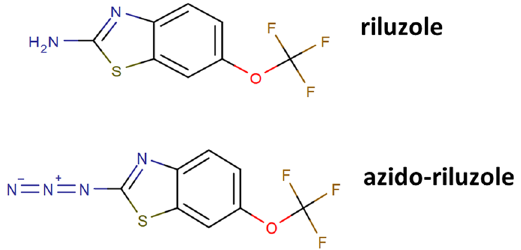
Figure 2. Chemical structure of riluzole and